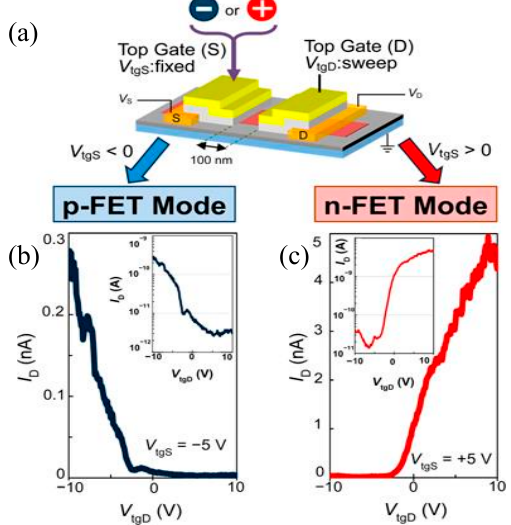
Figure 10. ( a ) Schematic of the MoTe 2 ambipolar transistor structure. The gap between the two top gates is 100 nm. ( b ) Experimental results for on/off operation in the p-FET mode (V tgS = -5 V). The inset is a logarithmic plot. ( c ) Experimental results of an on/off operation in the n-FET mode (V tgS = 5 V), with a logarithmic plot provided in the inset. Reproduced with permission from [160], American Chemical Society, 2015.